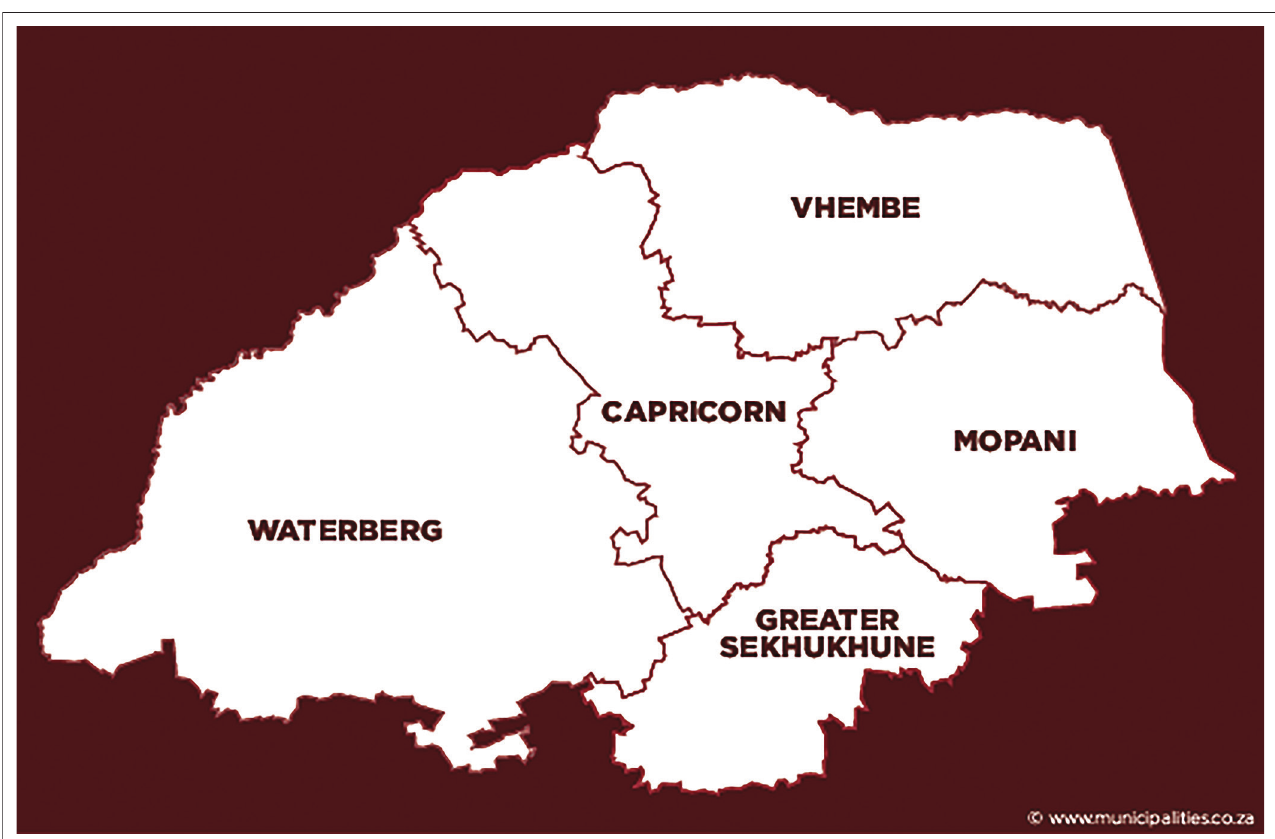
FIGURE 1: Map of the Limpopo